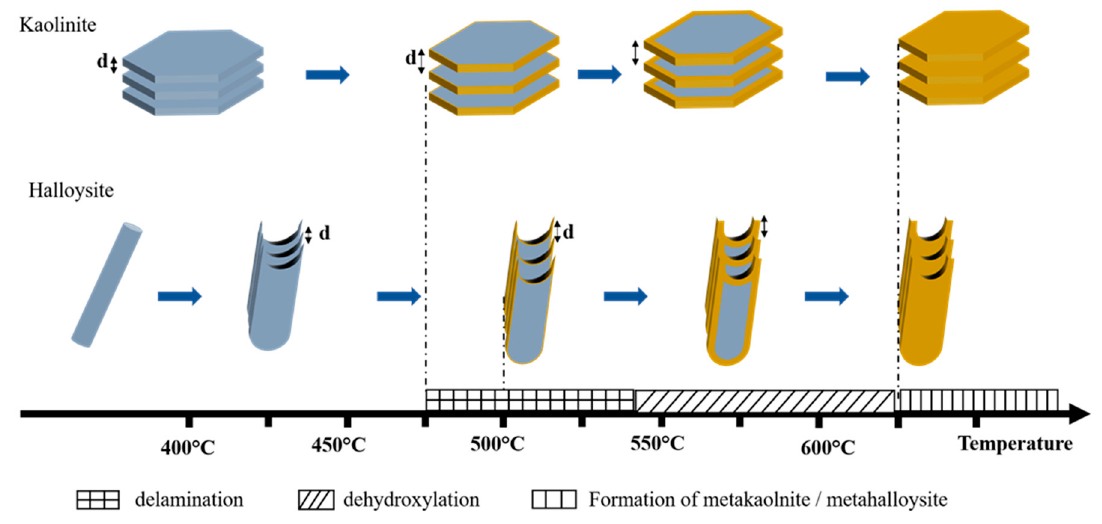
Figure 11. Suggested summarized dehydroxylation for the studied kaolinites and halloysite